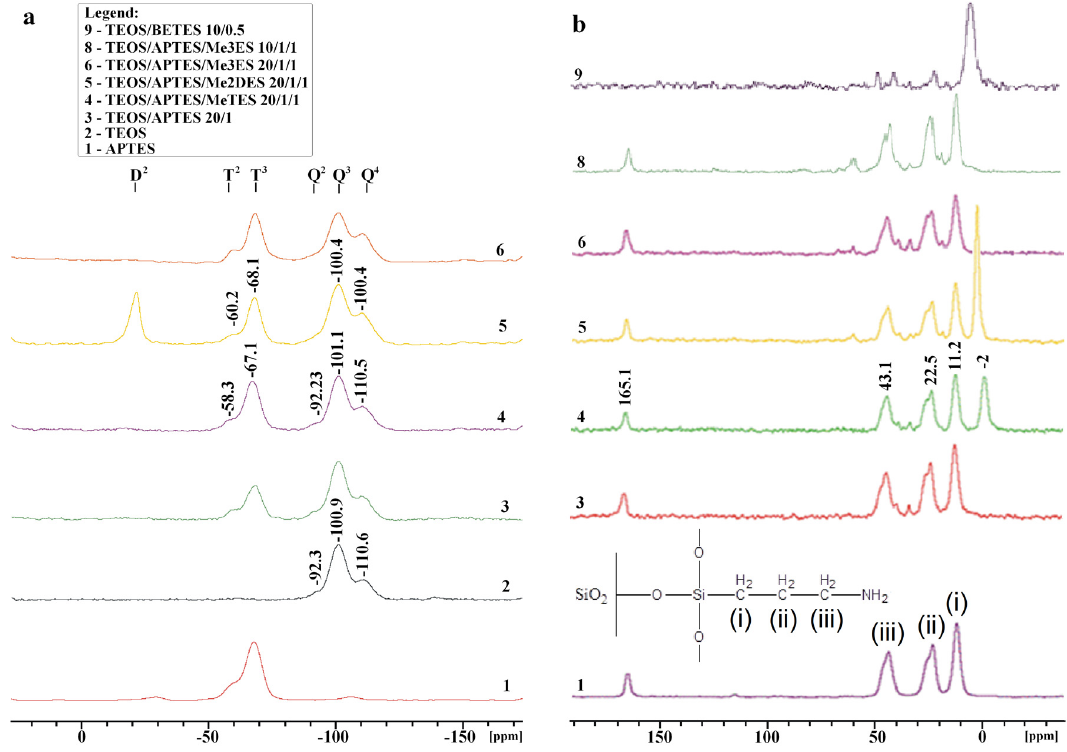
Figure 6. ( a ) 29 Si CP/MAS–NMR; and ( b ) 13 C CP/MAS–NMR solid state spectra of pristine and modified silica particles.